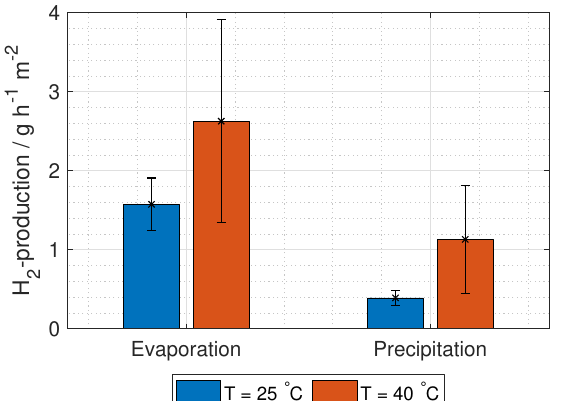
Figure 18. Hydrogen production per hour and unit cell area from RED using concentrations relevant for the separation techniques evaporation and precipitation.